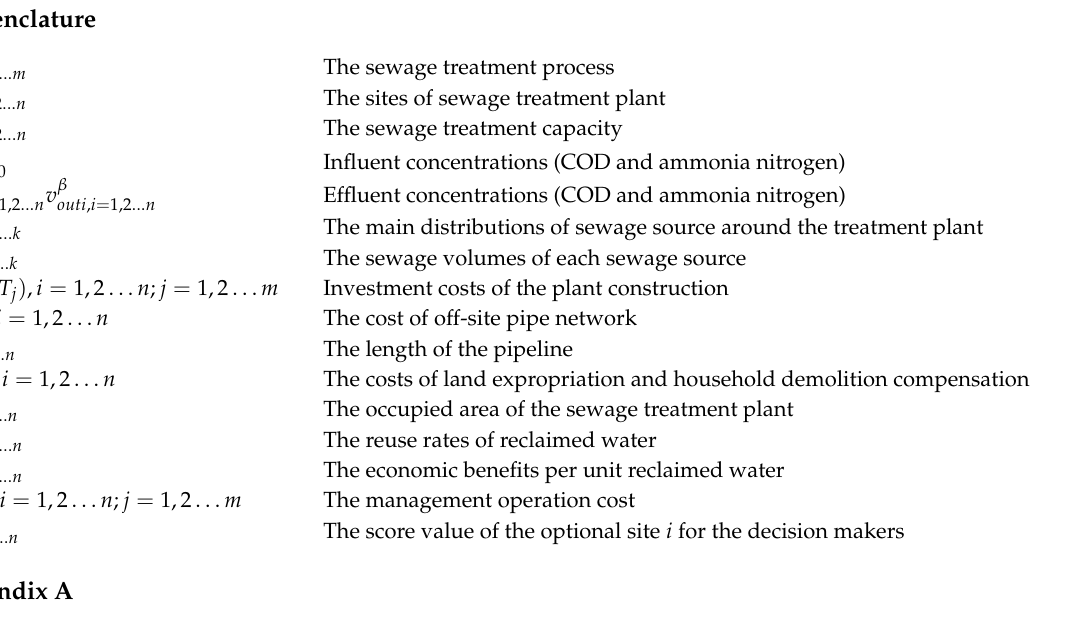
Table A1. The GA algorithm for the sewage treatment